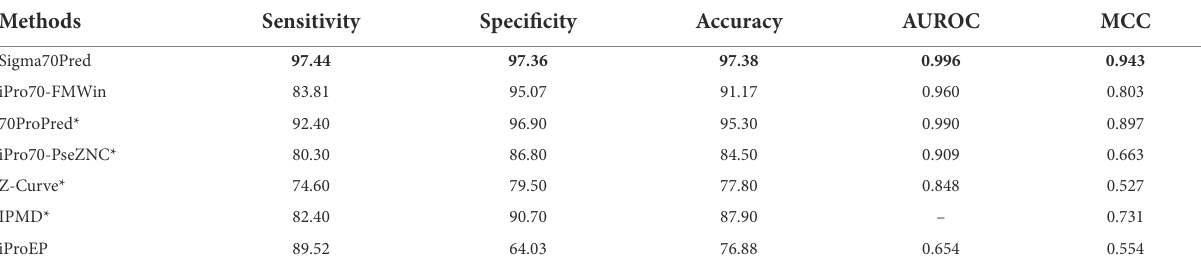
TABLE 2 Comparison of performances of our model with existing method on benchmark dataset evaluated using cross-validation